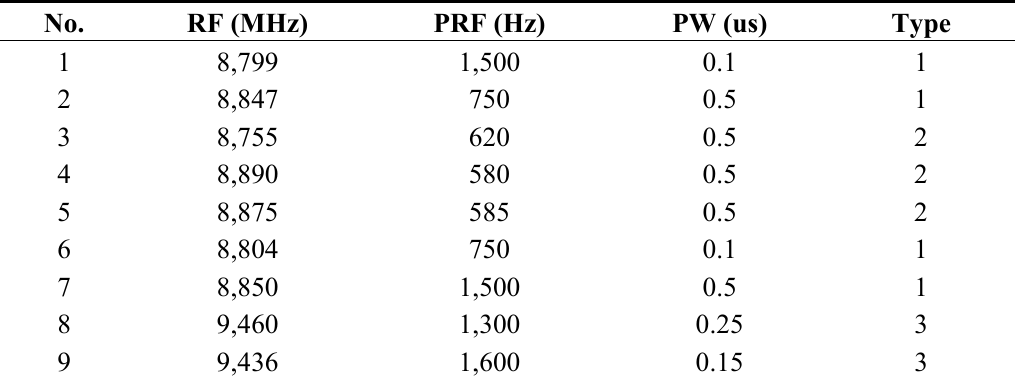
Table 1. Information of known radar emitter signals.